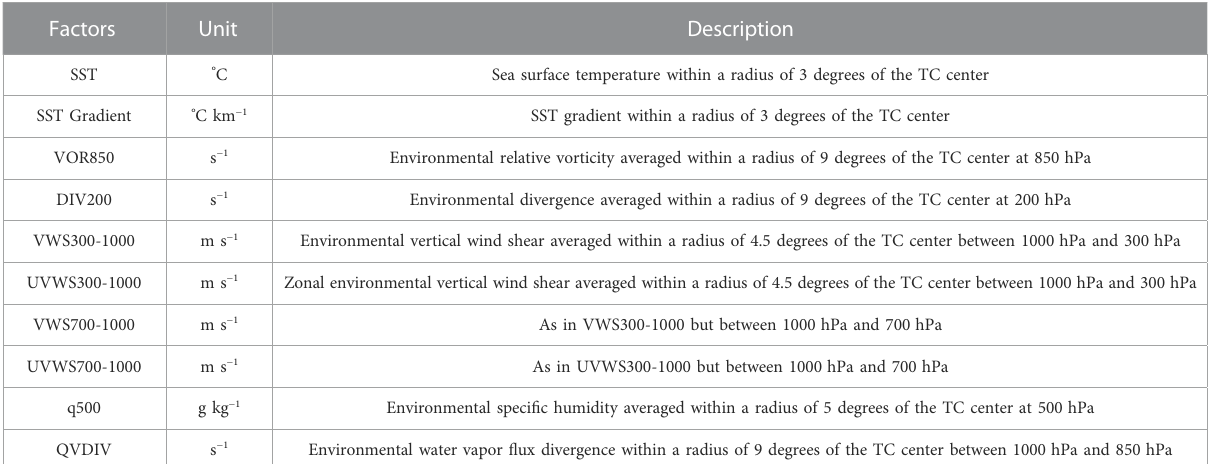
TABLE 1 The factors analyzed in this study with their units and descriptions